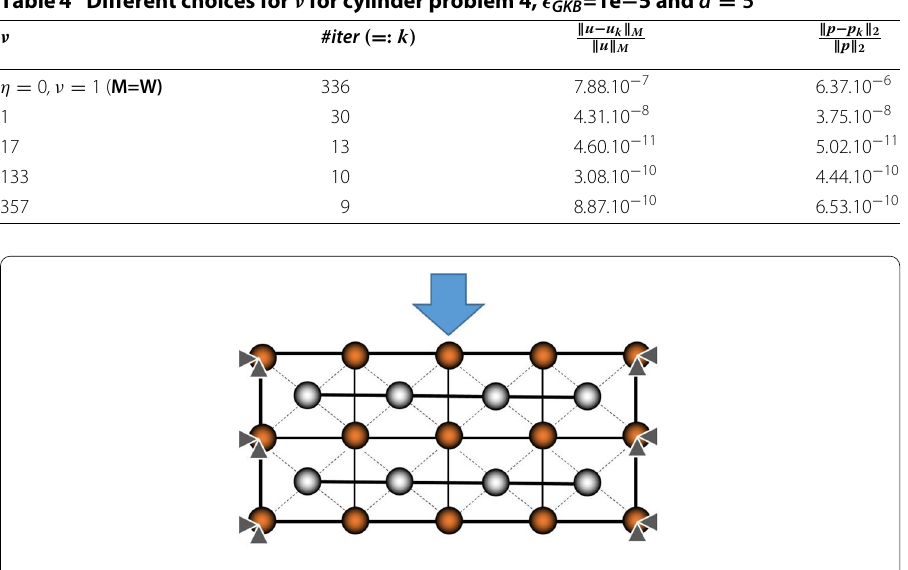
Fig. 5 Simple model of prestressed